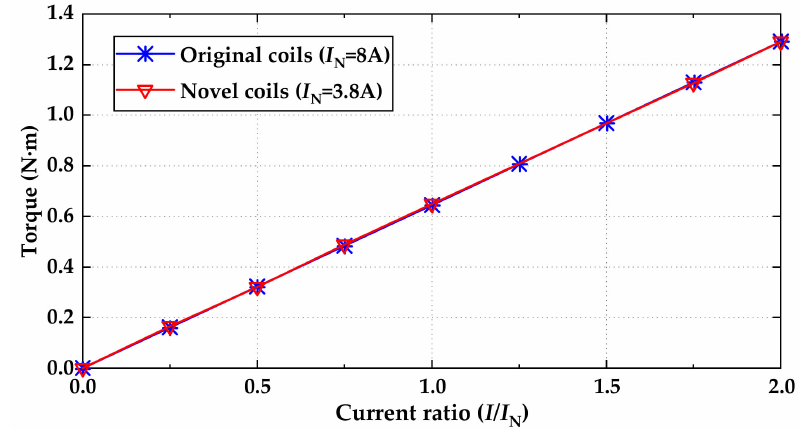
Figure 10. Torque variation with different phase